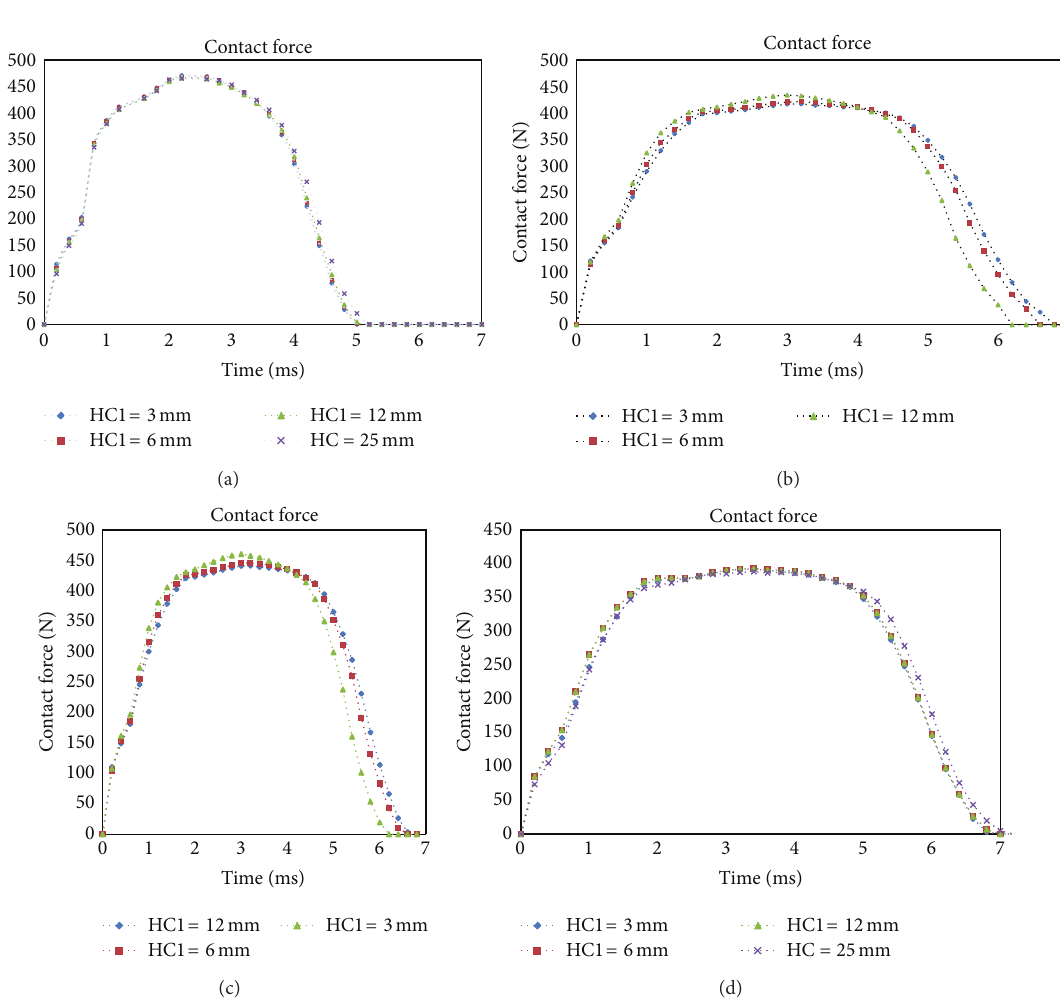
Figure 4: Contact forces of the different locations of internal sheet: (a) Case 1: EPP-EPP; (b) Case 2: EPP-PUR; (c) Case 3: PUR-EPP; (d) Case 4: PUR-PUR.